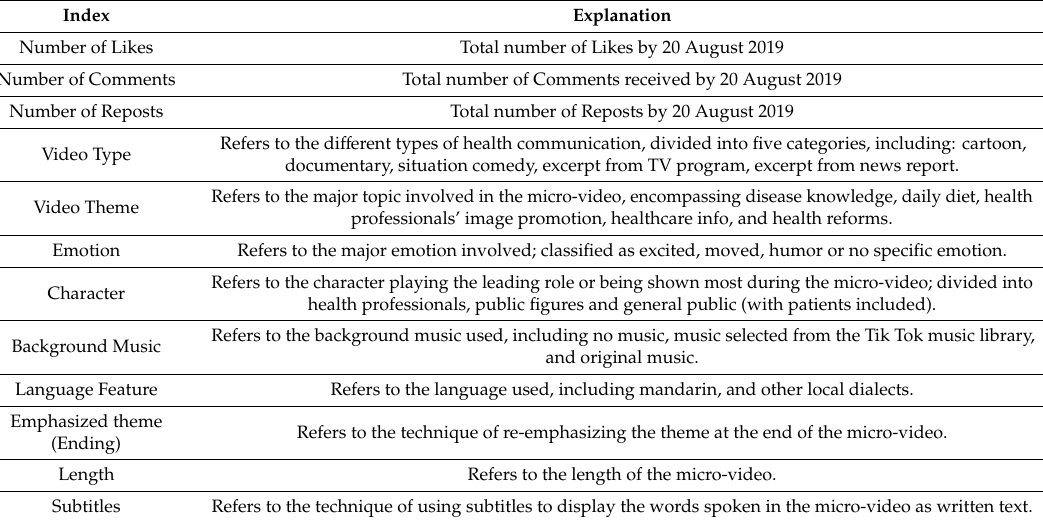
Figure 1. The coding framework for the top 100 most liked micro-videos run by Provincial Health Committees (PHCs). Table 1. The coding scheme for video